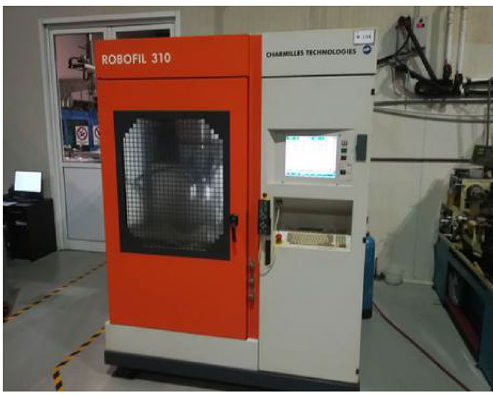
Fig. 4 A sample being manufactured by the wire-cut machine